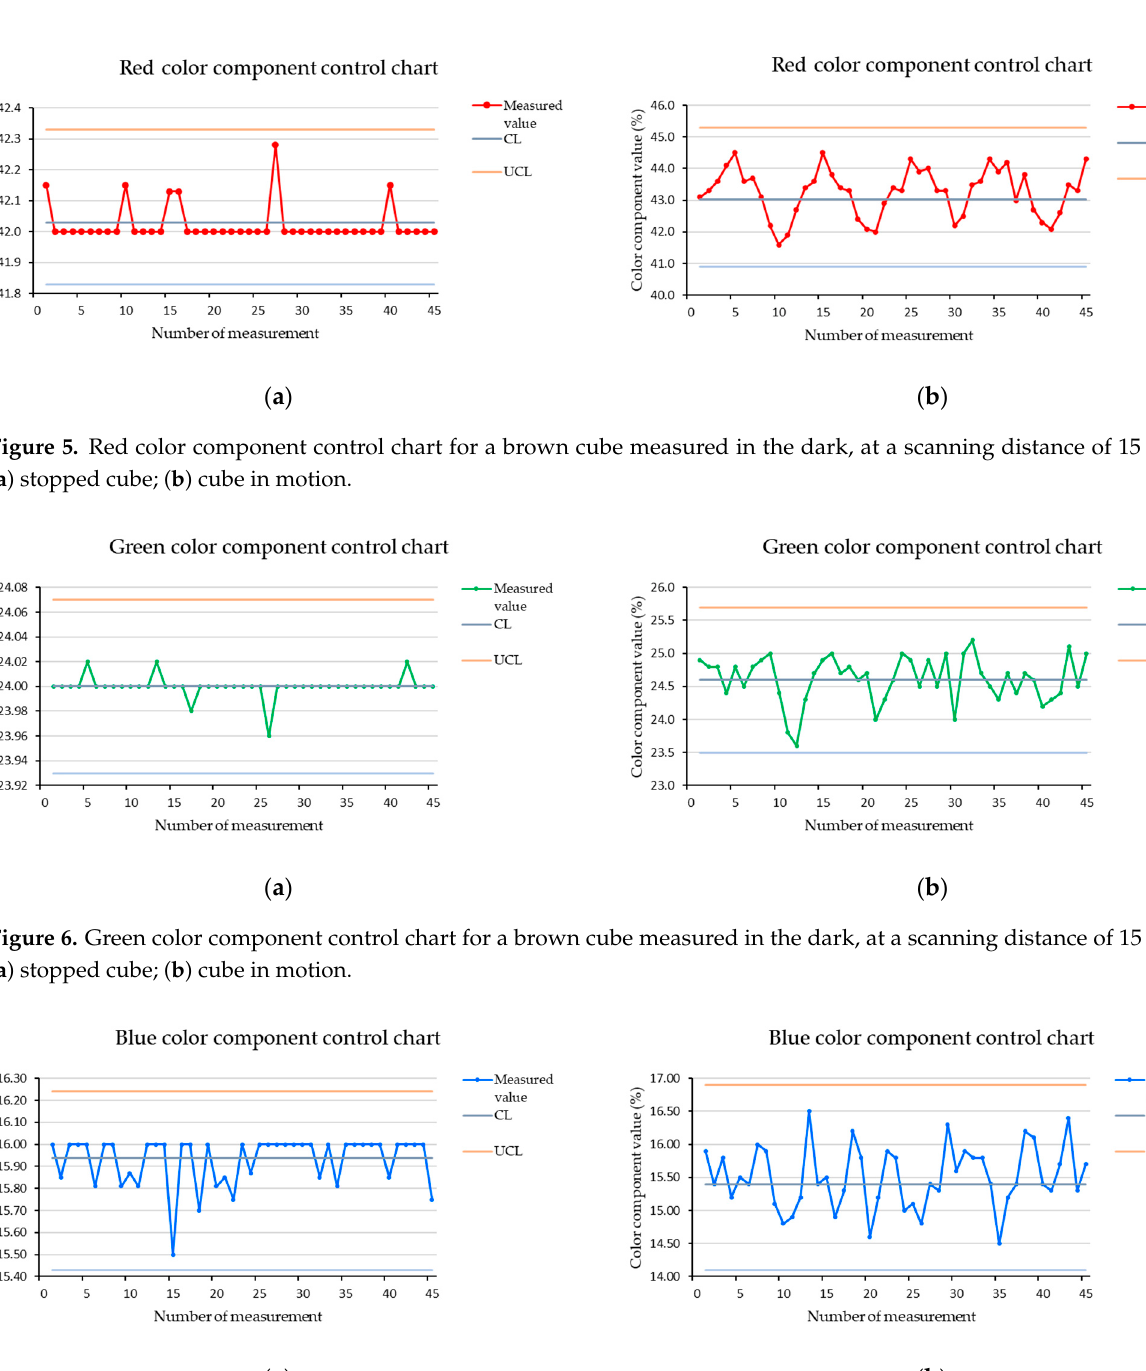
Figure 6. Green color component control chart for a brown cube measured in the dark, at a scanning distance of 15 mm; ( a ) stopped cube; ( b ) cube in motion.